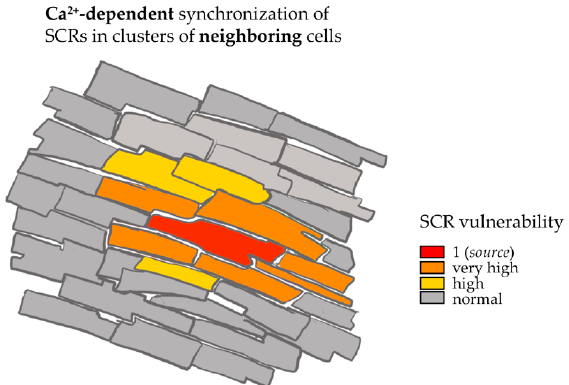
Figure 6. Factors potentially contributing to synchronization of diastolic depolarization in the myocardium. A “source–sink–source” model, showing the effect of a SCR occurring in one myocardial excitable cell (red labeled “source” cell) on vulnerability of surrounding CM to develop, in turn, diastolic “SR leak” and SCR. This positive feedback loop may, thus, “regenerate” a current source, enlarging the area of CMs depolarizing synchronously.